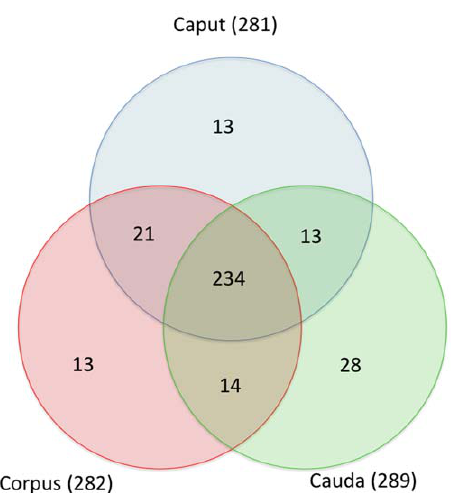
Figure 1. Venn diagram comparing miRNA expression in three human epididymal regions (caput, corpus and cauda). A threshold has been applied to detect miRNAs expressed with a Log 2 intensity . 3.2 in at least one epididymal region.